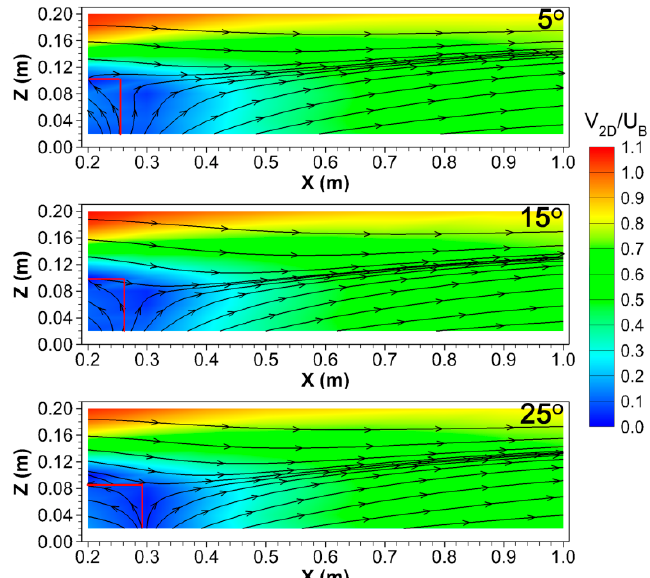
Figure 9. Air streamlines with contours of normalised air velocity magnitude ( V 2D / U B ) at Plane 3 for roof slopes of 5°, 15°, and 25°. U B is the streamwise air velocity at the building height. Red lines indicate the height and length of the wake for each case.